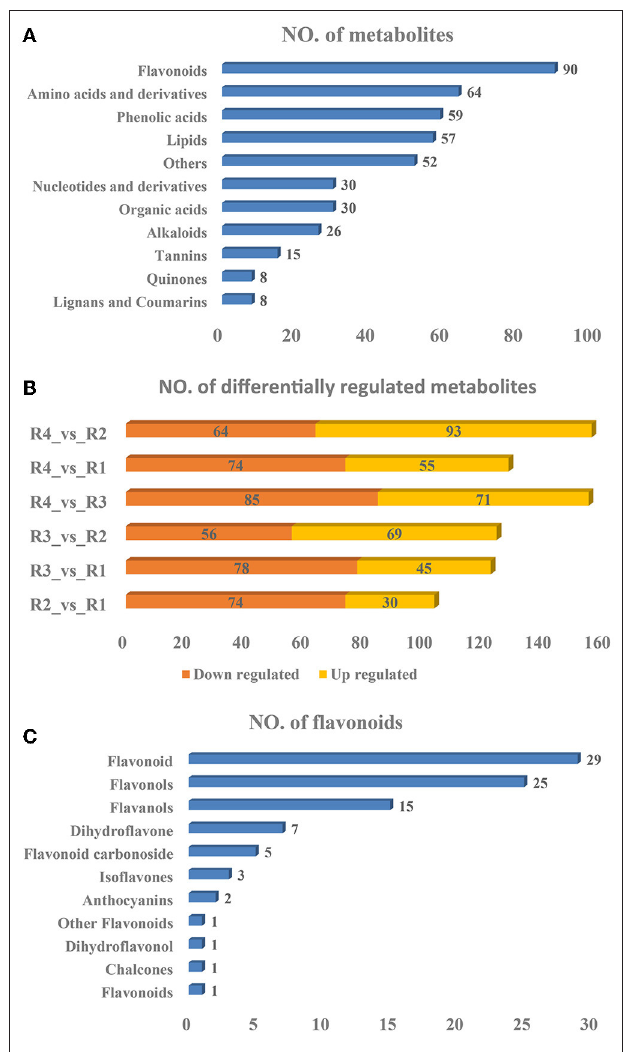
FIGURE 2 | Statistics of the (A) identified metabolites, (B) differentially regulated metabolites, and (C) flavonoids of golden buckwheat rhizomes based on metabolomics